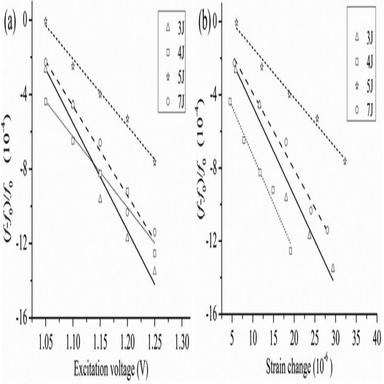
Relative frequency shift relations with excitation voltage and strain change: (a) excitation voltage, (b) strain change.